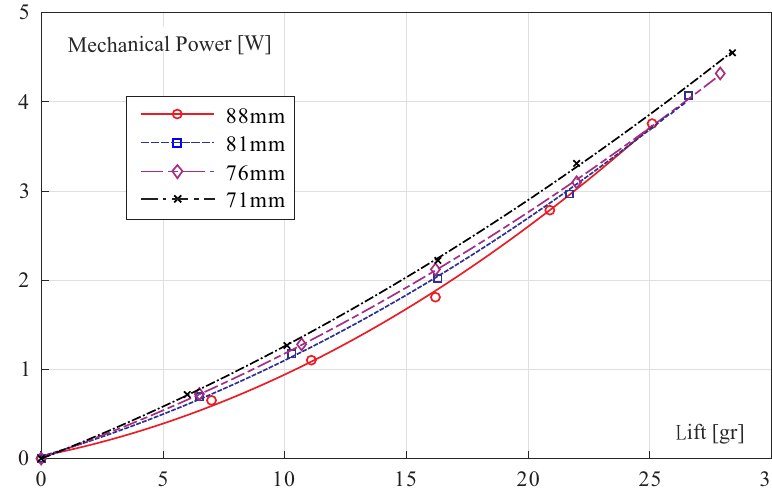
Figure 6. Mechanical power P m vs. lift L for the wings of Figure 4. A trailing edge serration similar to that of natural hummingbirds has also been tested (Figure 7). The lift versus flapping frequency curves are shown in Figure 8 and the mechanical power versus lift is presented in Figure 9. No significant difference is observed in the mechanical power necessary to achieve a given lift; as in the previous case, the only difference is that the lift is obtained for a lower frequency when the wing area is larger. These wing shapes have not been studied further.